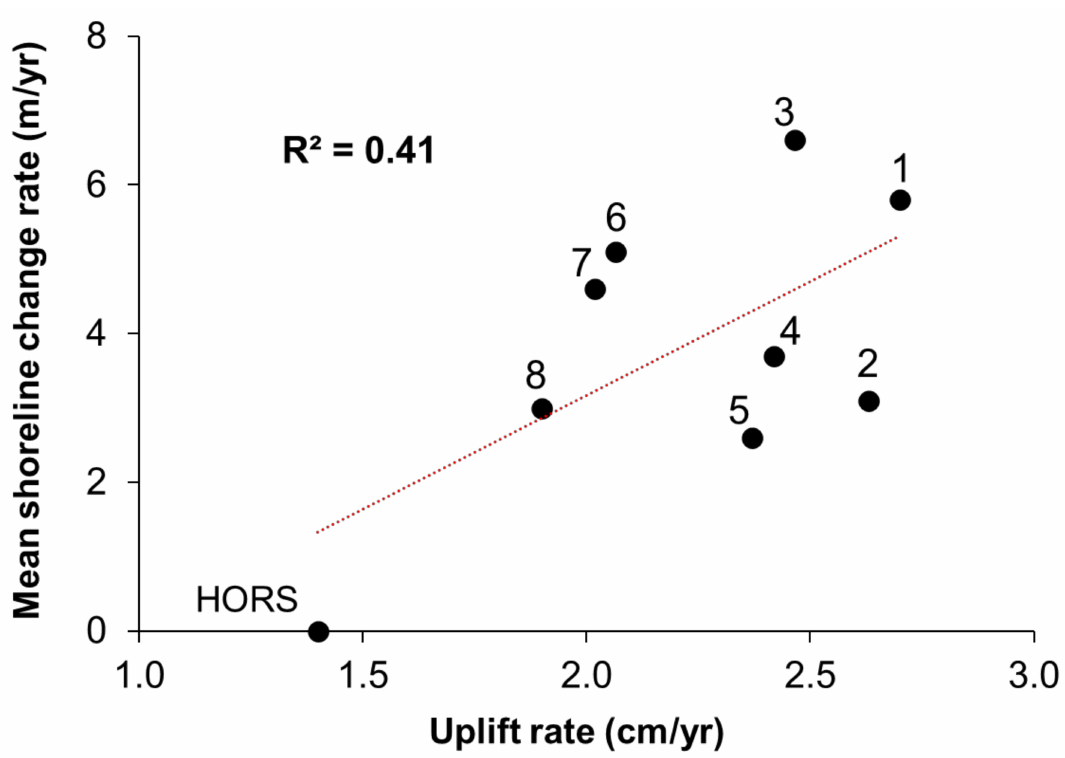
Figure 8. Shoreline recovery rate and rate of uplift along the coast after the earthquake (numbers represent sandy